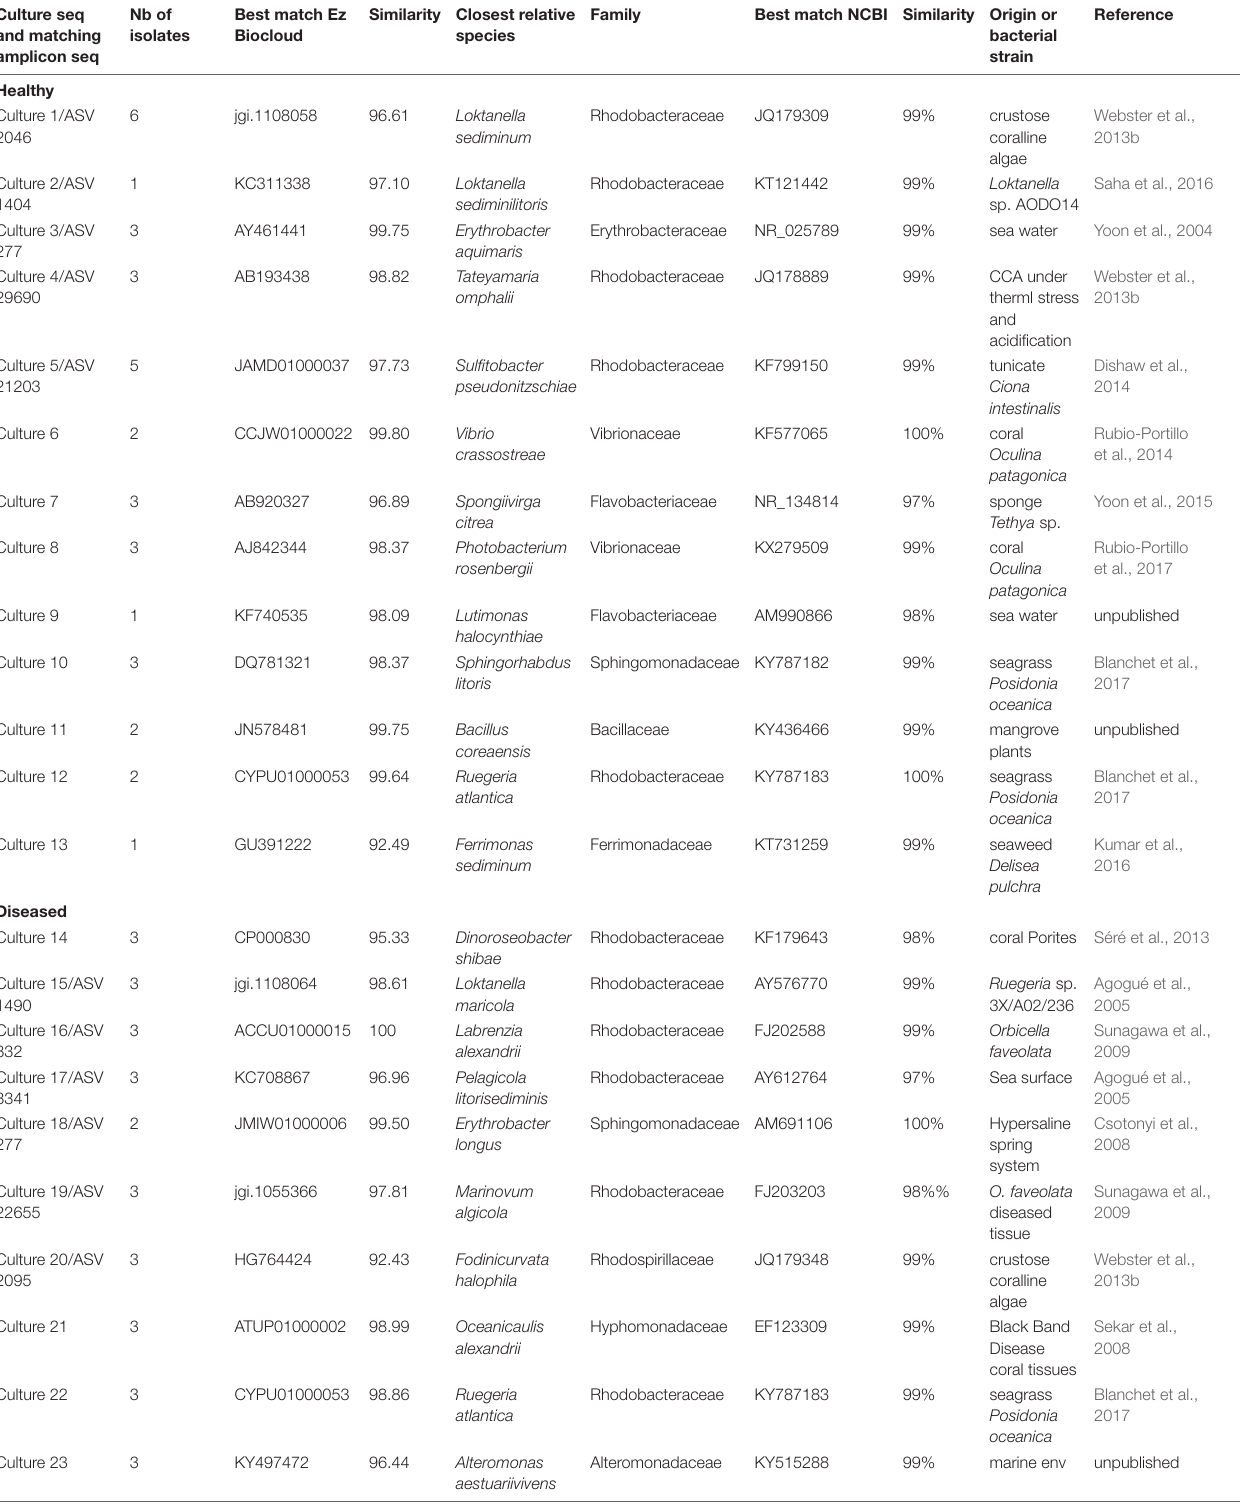
TABLE 2 | OTUs obtained from bacterial isolates cultured from CCA samples and their best match among the ASVs obtained from NGS. Culture seq Nb of and matching amplicon seq